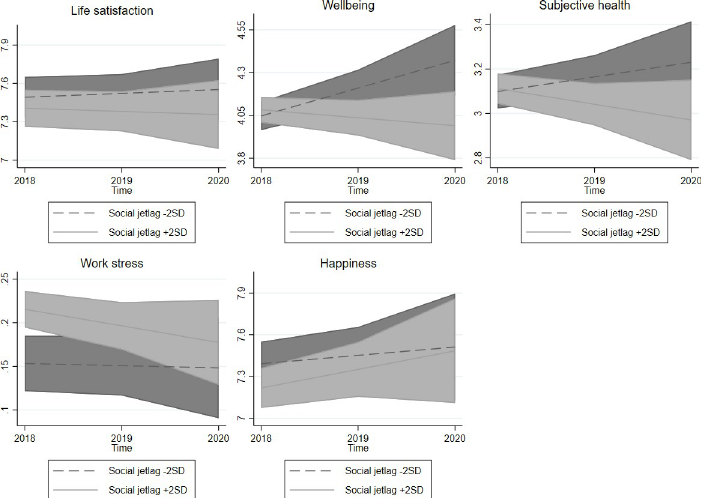
Fig 4. Social jetlag and quality of life at the individual level in time. Note: 95% confidence intervals.